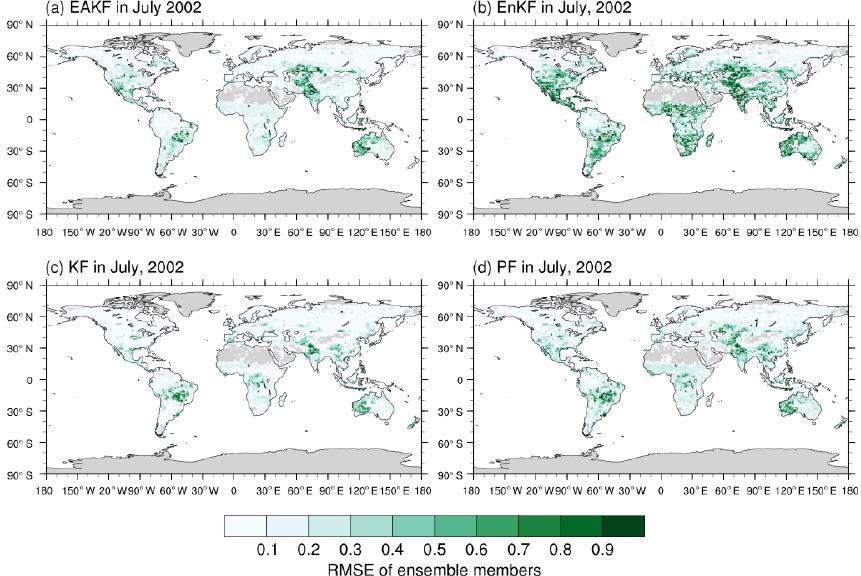
Figure 3. Same as Fig. 2 but for RMSE of ensemble